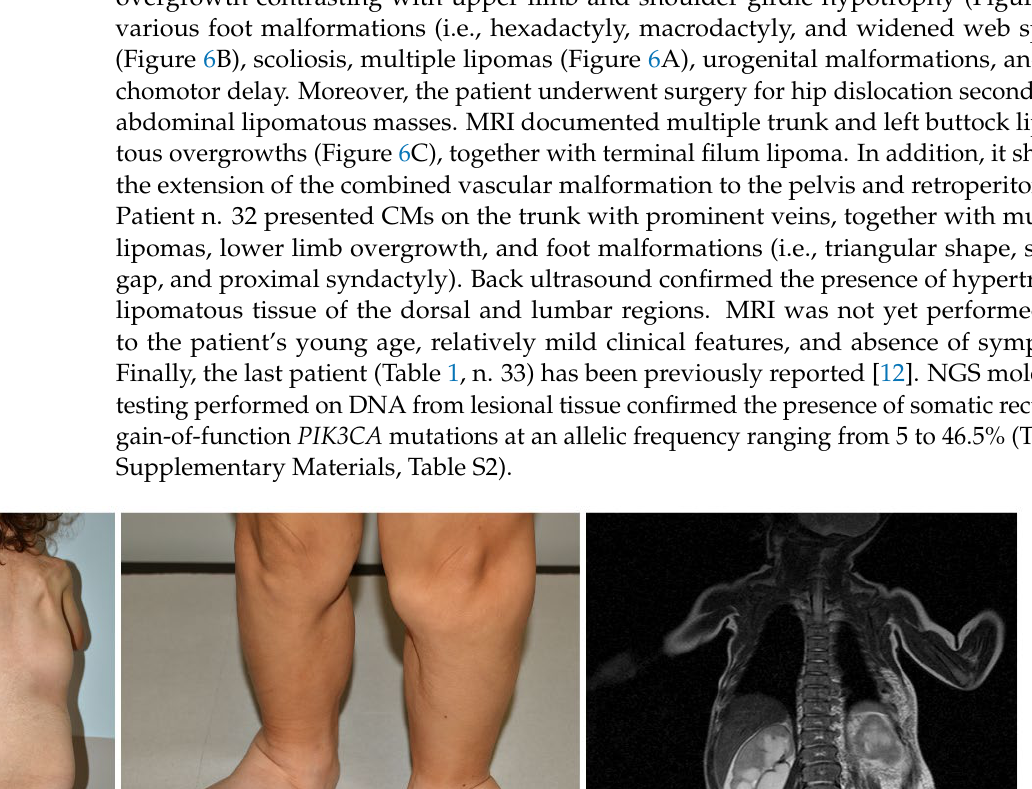
Figure 7. Clinical and imaging features of Klippel–Trenaunay syndrome: A 3-year-old girl (Table 1, n. 35) presents a combined capillary–venous–lymphatic malformation on her left buttock and lower limb (including the toes), with overgrowth ( A ). CT scan shows a persistent embryonic superficial vein ( B , asterisks). Note the clinical similarity of the vascular malformation in Klippel–Trenaunay ( A ) and CLOVES (Figure 6A) with an isolated combined capillary–lymphatic malformation of the right flank in a 1-year-old male infant (Table 1, n. 36) ( C ). 3.7. Blue Rubber Bleb Nevus Syndrome The two patients with BRBN syndrome (Table 1, n. 40, 41) presented typical clinical features, i.e., multiple cutaneous and subcutaneous bluish papules and nodules, which increased with age and also involved the palmoplantar surfaces (Figure 8A,B,D), a con- genital plaque-like larger lesion (Figure 8C), and gastrointestinal venous malformations. Patient n. 40, an adult female, suffered from chronic anemia and recurrent gastrointestinal bleeding, which required multiple endoscopic laser treatments. In this patient, MRI doc- umented cerebral, hepatic, and bone osteolytic vascular nodules. Both patients had double variants in the TEK gene; they carried the known missense somatic mutation affecting Tyr897, in combination with two somatic missense variants: c.2800T > C (p.Ser934Pro) (patient n. 40) and c.2743C > A (p.Arg915Ser) (patient n. 41) (Figure 9). In each patient, the two variants were detected at the same allele frequency, i.e., 1%, by NGS. In addition, in patient 41, the two variants (i.e., p.Tyr897Phe and p.Arg915Ser) were present on the same